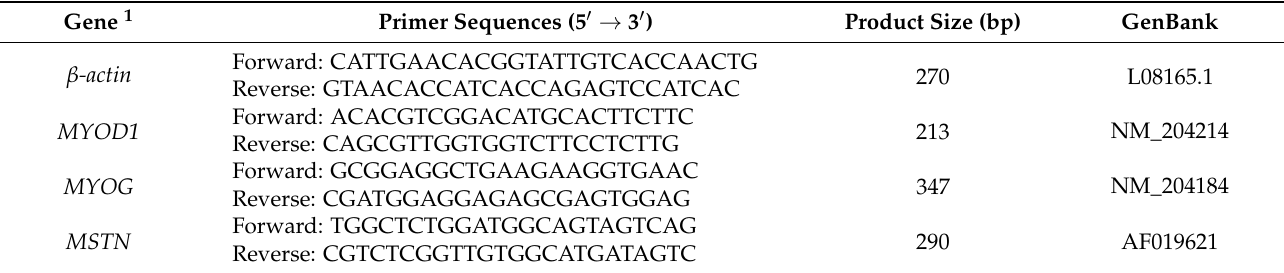
Table 2. Primer sequences for RT-qPCR in this